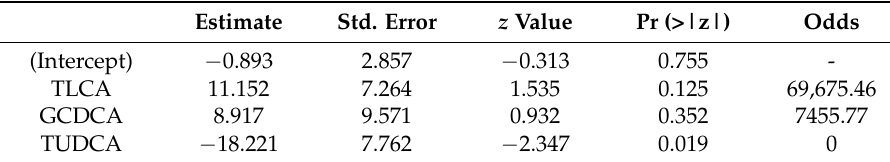
Table 2. Logistic Regression Model—Summary of Each Feature.